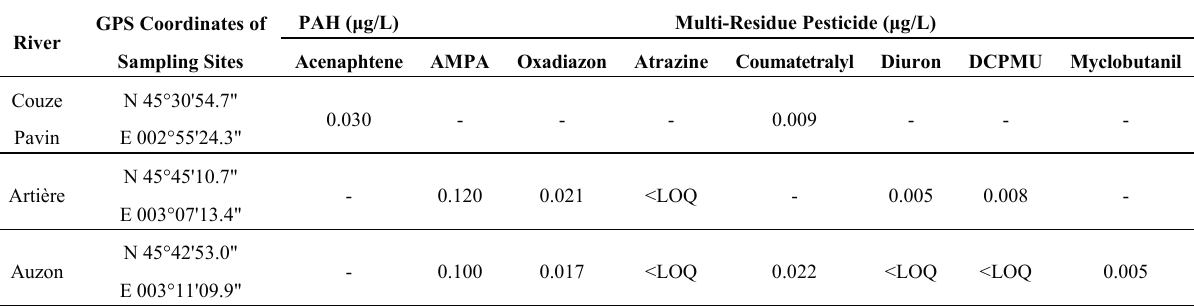
Table 1. Organic micropollutants analyses in different rivers located in different